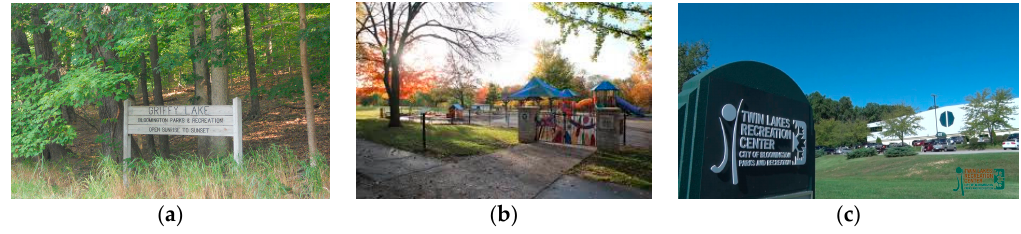
Figure 1. ( a ) Site A (natural setting), ( b ) Site B (semi-natural) (source: visitbloomington.com), ( c ) Site C (urban built).